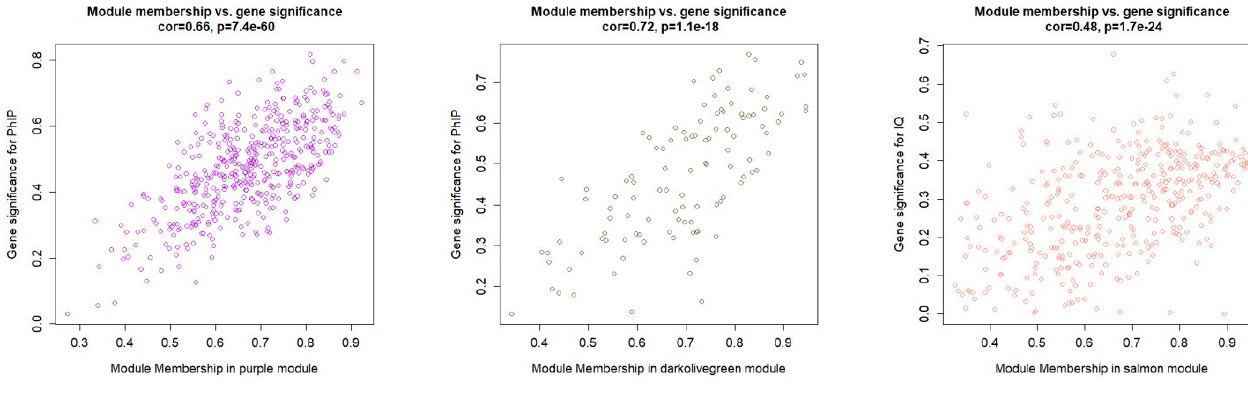
Figure 2. The scatterplot of gene significance for weight vs. module membership in the purple, darkolivegreen, turquoise, saddlebrown, and salmon modules. The correlation was calculated with the absolute value of gene significance and mod- ule membership, which illustrates the association between genes and the trait. 3.2. Functional Analysis of the Correlated Gene Moudules To explore the function of the correlated gene modules, GO and KEGG enrichment analyses were performed on correlated gene modules. As is shown in Figure 3, genes from the five relevant gene modules were enriched in different gene functions. The four PhIP relevant modules: purple, darkolivegreen, turquoise and saddlebrown, were annotated mainly with mRNA transcriptional regulation, mitocondral function, RNA catabolic pro- cess, protein targeting, and immune function. The salmon module, which is the only IQ relevant module, was annotated mainly with immunological cell response.